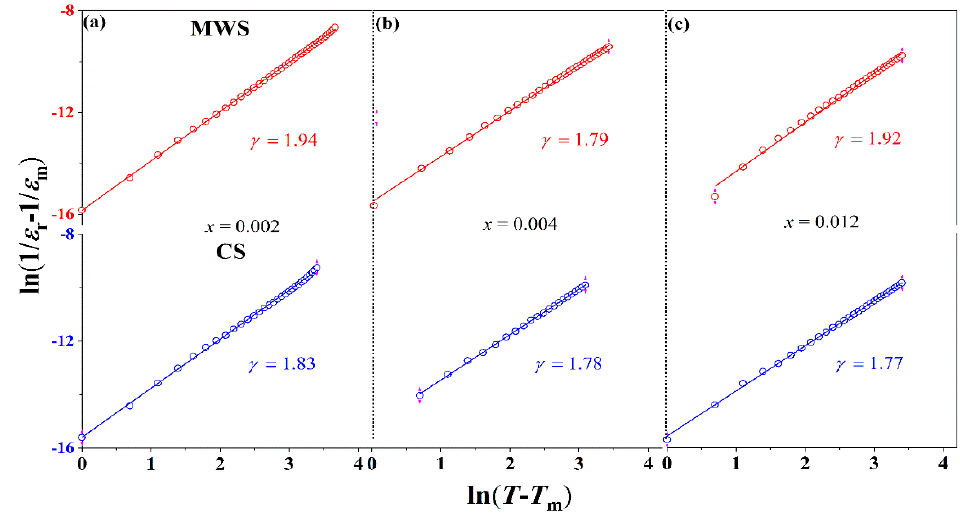
Figure 3. Plots of ln(1/ ε r − 1/ ε m ) versus ln( T − T m ) of BST-BCT- x BF ceramics with MWS and CS, (a) x = 0.002, (b) x = 0.004, (c) x = 0.012.